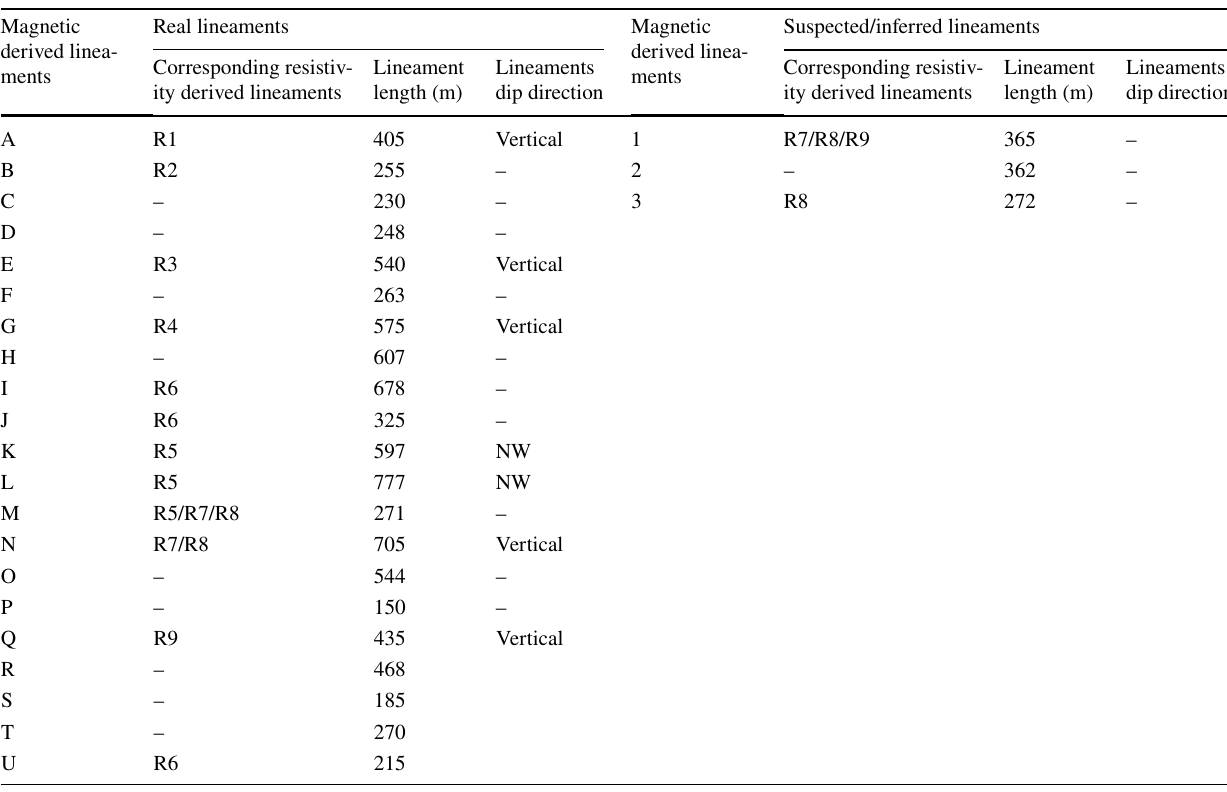
Table 2 Summary of the magnetic and resistivity derived lineaments Magnetic derived linea-